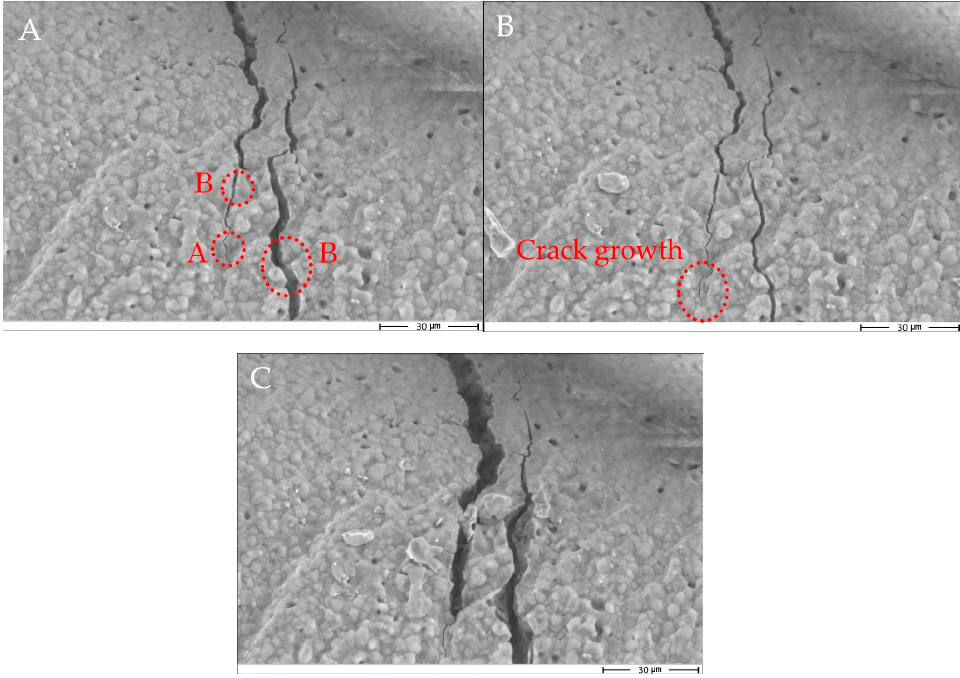
Figure 12. Cracks propagations through the microstructure of a porous sample under compressive loading taken by ESEM. (A) two parallel cracks propagated in opposite directions, (B) progression of the cracks tips by increasing the applied force, (C) condition of the cracks just before the final failure.